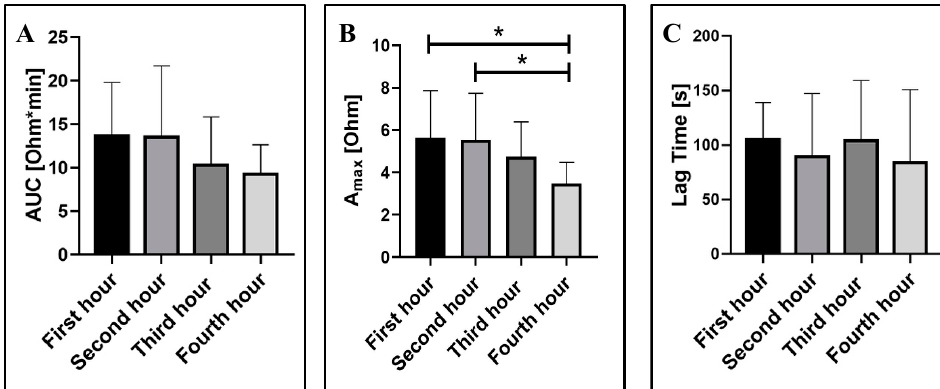
Figure 2. The effect of storage time on ADP-induced platelet aggregation in ACD-anticoagulated whole blood: ( A ) area under the curve (AUC); ( B ) maximum aggregation (Amax); and ( C ) lag time. Data from 6 independent experiments using blood samples from 6 different individuals are reported. Mean ± SD as error bars of aggregation parameters are indicated, ANOVA: no asterisk— p > 0.05; * p < 0.05.